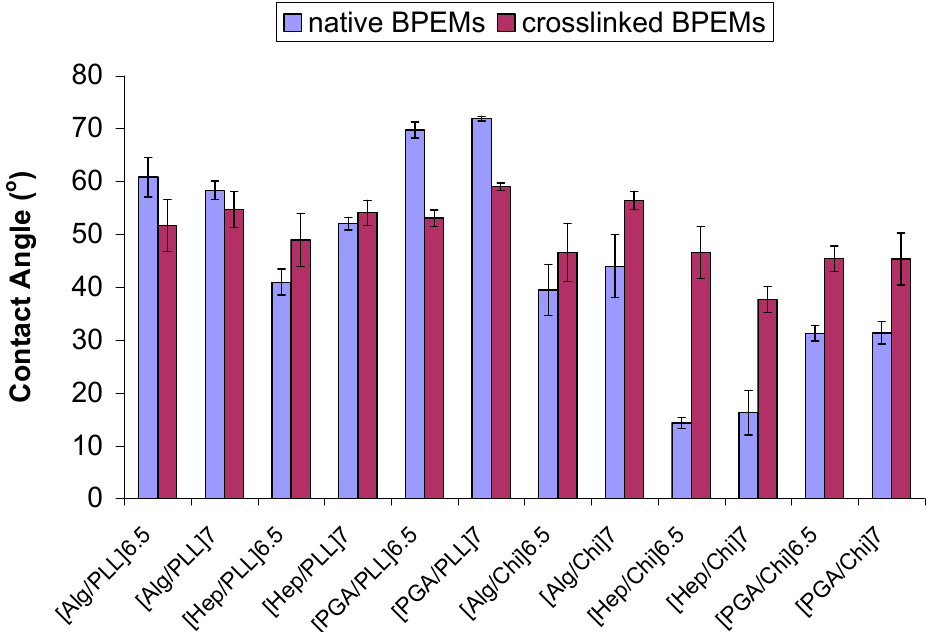
Figure 4. Static contact angles ( Ɵ static ) of nanofilms before and after crosslinking of BioPEMs. Error bars indicate 95% confidence intervals (n = 3).